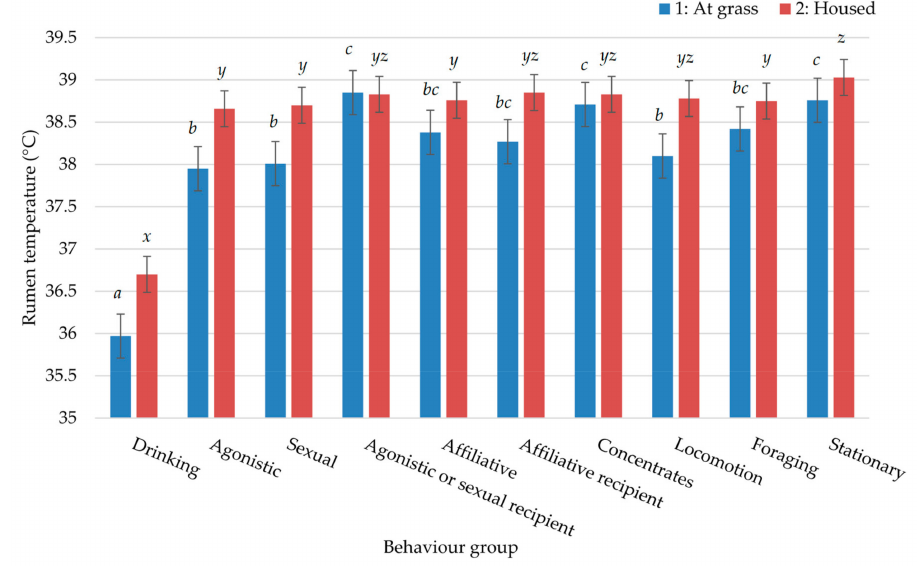
Figure 2. E ff ect of behaviour on rumen temperature during the two studies. a, b, c represent significant di ff erences ( p < 0.001) between behaviour groups in Study 1: at grass. x, y, z represent significant di ff erences ( p < 0.001) between behaviour groups in Study 2: housed.